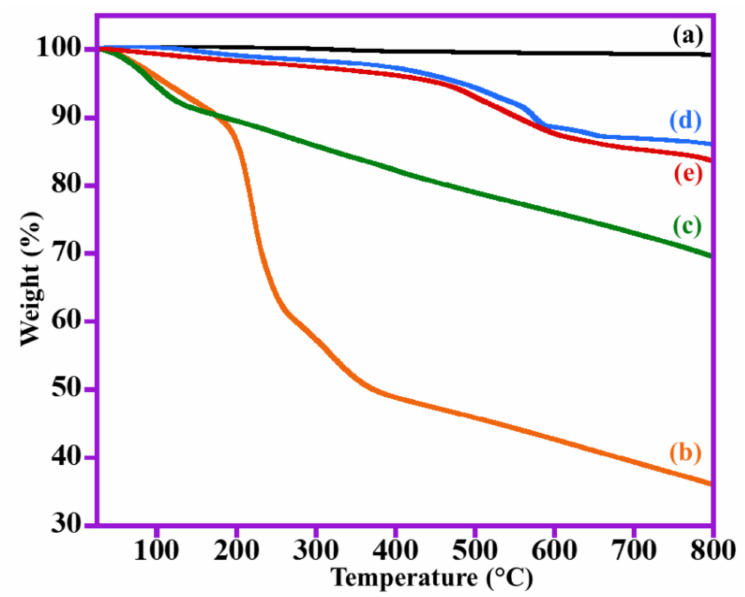
Figure 2. TGA thermogram of ( a ) graphite, ( b ) GO, ( c ) NDG, ( d ) un-doped (1%) ZnO–MnCO 3 catalyst, and ( e ) (1%)ZnO–MnCO 3 /(1%-NDG) nanocomposite. FT-IR spectra of the nanocomposite (1%) ZnO–MnCO 3 /(1%-NDG) is displayed in Figure 3 and FT-IR results of GO and NDG is also presented for comparison. In pure GO, the band observed at ~3438 cm − 1 is related to the vibrations of (O − H) bond or physisorbed H 2 O molecules [49]. The FT-IR peaks located at 1736 cm − 1 and 1632 cm − 1 were assigned to (C=O) vibrational modes and carbon backbone stretching vibrations from un-oxidized graphitic domains, correspondingly [50]. The other absorption peaks observed at 1396, 1227, and 1061 cm − 1 are attributed to vibrations of oxygenic-groups like C–OH, C–O– C (epoxy), and C–O (alkoxy) bonds, correspondingly [51]. The characteristic peaks of oxygenic-functionalities considerably weakened and/or disappeared in the spectrum of pure NDG and (1%) ZnO–MnCO 3 /(1%-NDG) nanocomposite, which confirm the effective reduction of GO to NDG. With respect to NDG spectra, some characteristic absorption bands are noticed at 3430 and 1562 cm − 1 which belong to N − H stretching vibrations and the peak at ~1152 cm − 1 is associated with C–N [52]. The spectra of (1%) ZnO–MnCO 3 /(1%- NDG) exhibits a weak peak at 1634 cm − 1 due to the vibrations of (C=C) bond, in addition, two strong peaks are present at 865 and 730 cm − 1 and a wide band exists at 1446 cm − 1 , which are similar to the peaks that appeared in the IR spectrum of MnCO 3 [53]. Moreover, the broad band at 3430 cm − 1 is associated with vibrations of N − H and the absorption peak at 1152 cm − 1 related to (C − N). Lastly, the strong band emerging at 584 cm − 1 is due to the vibrations of Mn–O bond